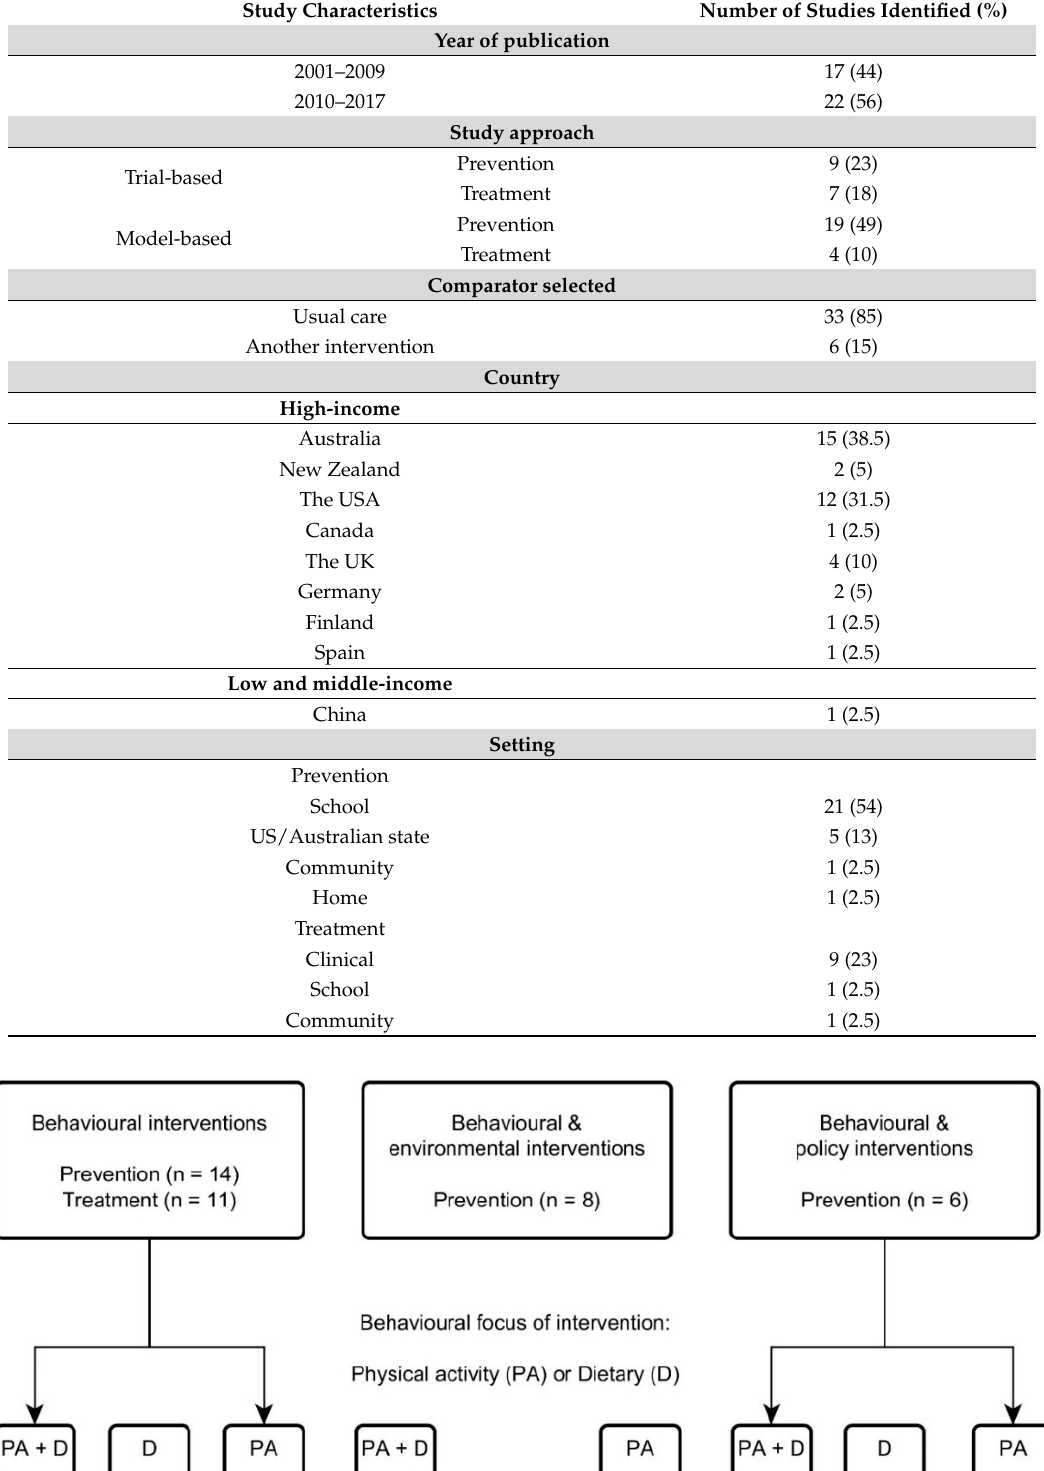
Table 1. Summary of general characteristics of the studies.